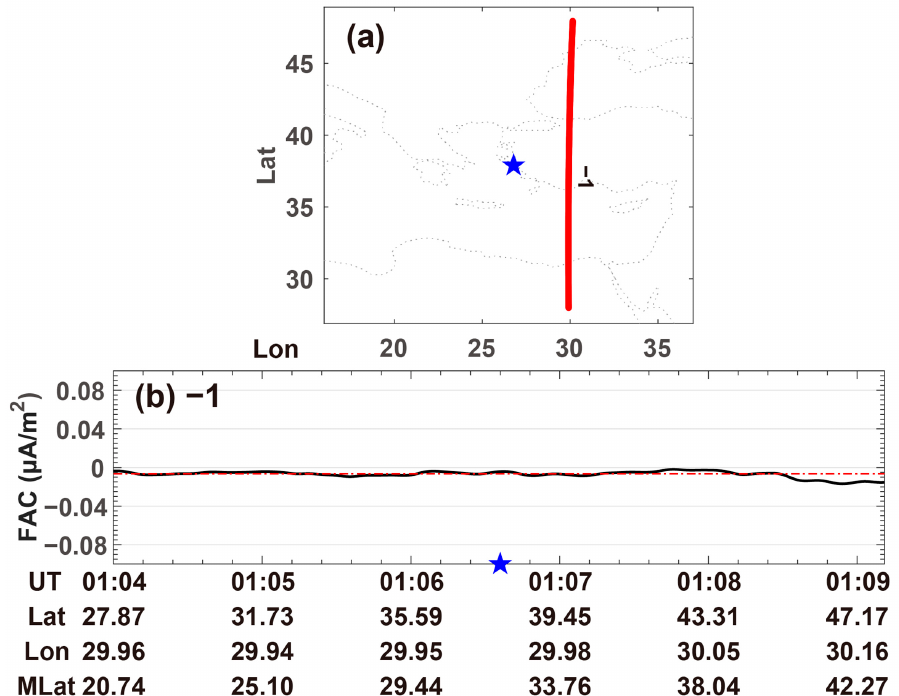
Figure A3. Field-aligned currents (LT~03) derived from the Swarm A and C pair in the range of 10° latitude by 10° longitude centered on the M7.0 earthquake. There is no FAC data at Δ T = − 8 and − 3 days. (a) Orbits on Δ T = − 1 day, blue star indicates the epicenter; (b) FACs along orbits on day − 1, and blue star shows the epicenter’s latitude.